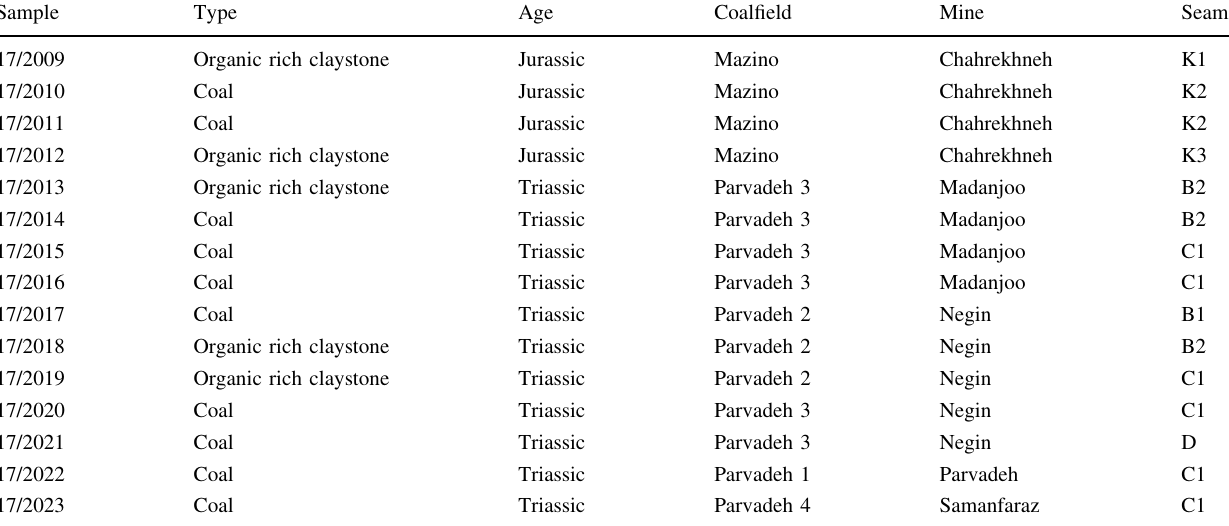
Table 1 Sample types and sampling locations